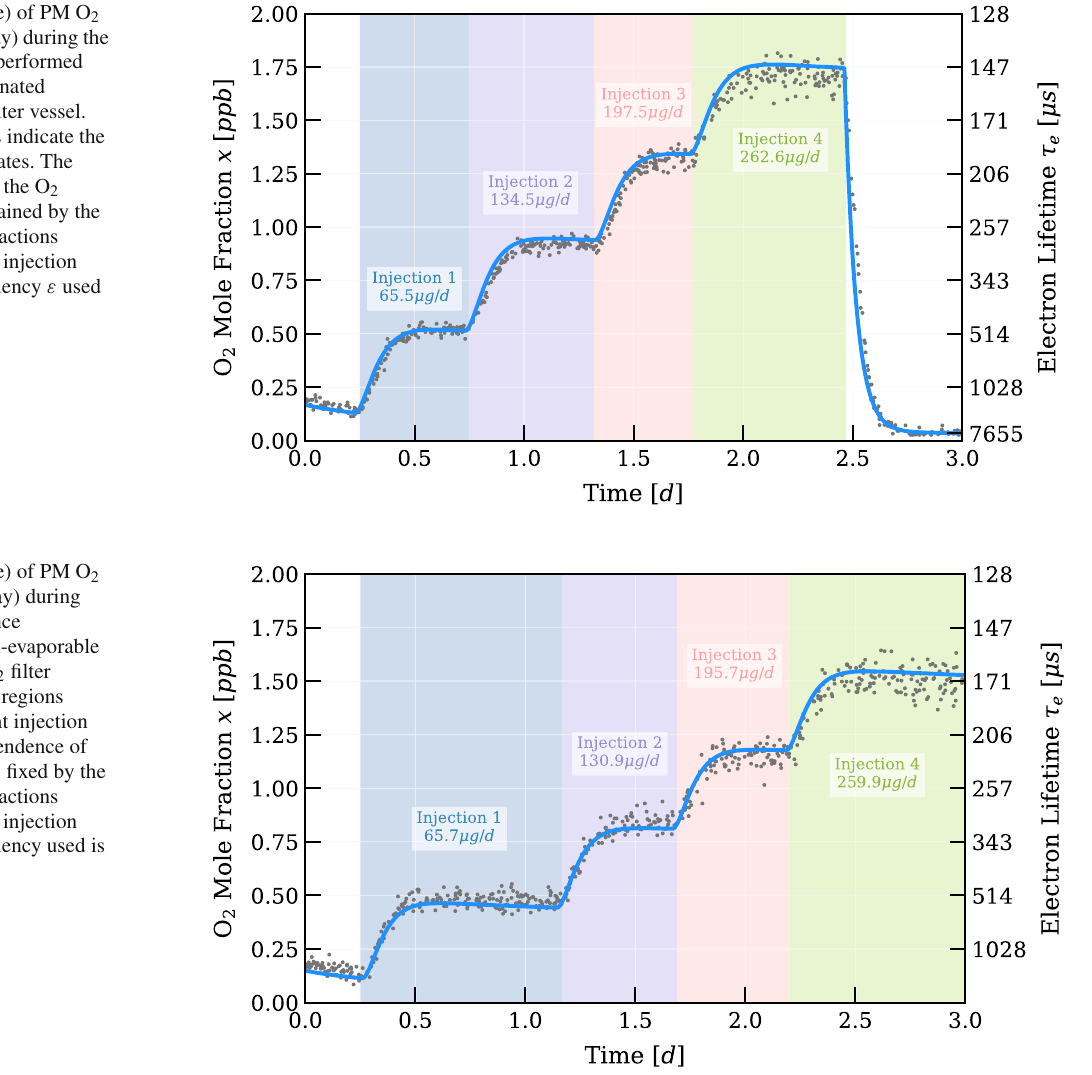
Fig. 7 Model (blue) of PM O 2 mole fraction x (gray) during the injection sequence performed with copper-impregnated spheres in the O 2 filter vessel. The colored regions indicate the different injection rates. The time dependence of the O 2 source Λ P is constrained by the equilibrium mole fractions before and after the injection sequence. The efficiency ε used is 0 . 92